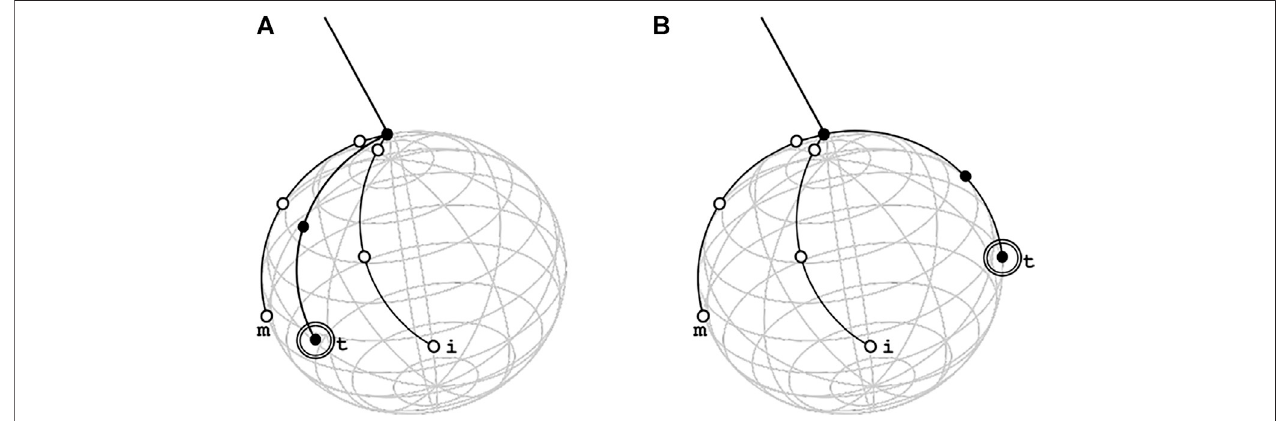
FIGURE6| Graphicrepresentationofthumbindeterminacyinretractormethodwithtworeachablepositions,inthecorrectonein (A) thethumbisbetweenmiddle and indextoallowthehandtoreachthepositionscoop-likewhile inwrongone,depictedin (B) ,thethumbisinopposition respecttheothertwo fi ngers andthereached posed of MUSHA hand is equal to approach pose in power grasp method. This is a consequence of the high similarity between the virtual spheres generated by the contact points in the Rt case and in the Po case.